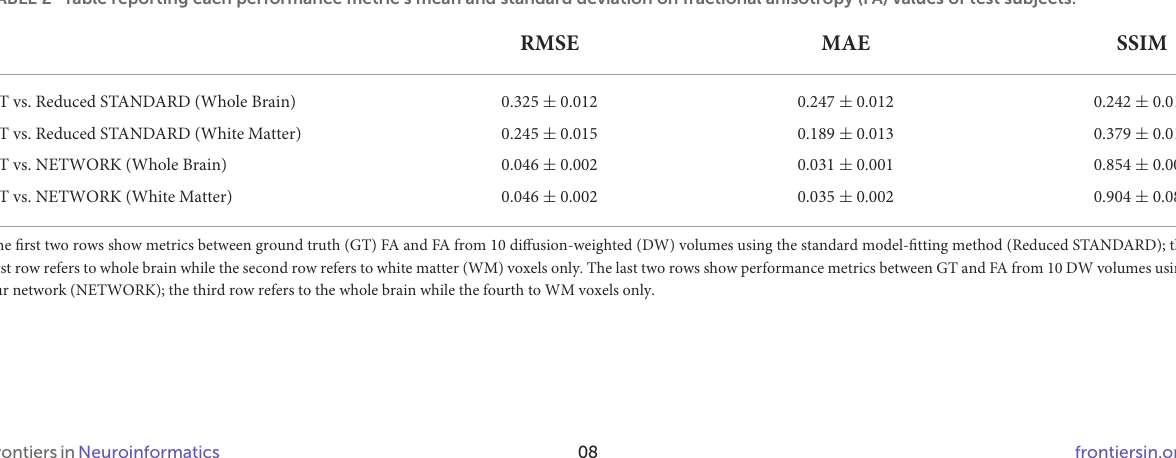
TABLE 2 Table reporting each performance metric’s mean and standard deviation on fractional anisotropy (FA) values of test